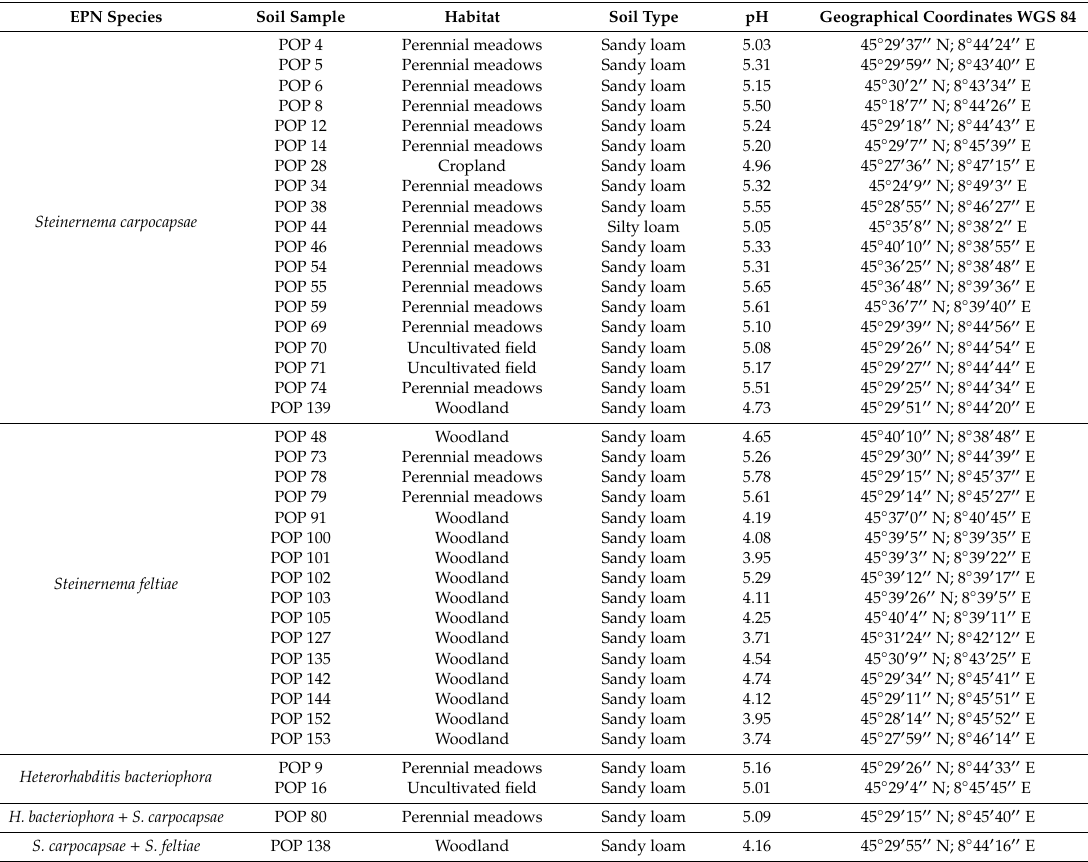
Table 1. Natural distribution of entomopathogenic nematodes in Popillia japonica -infested areas in the Piedmont